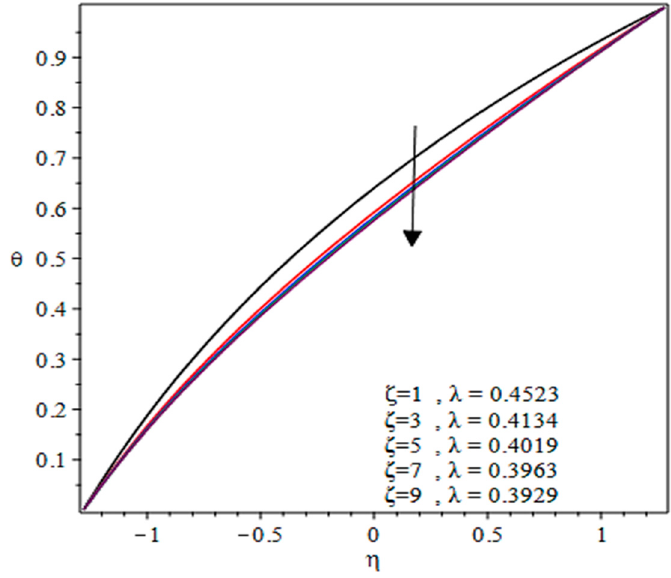
ζ ζ influence on the temperature distribution at influence on the temperature distribution at